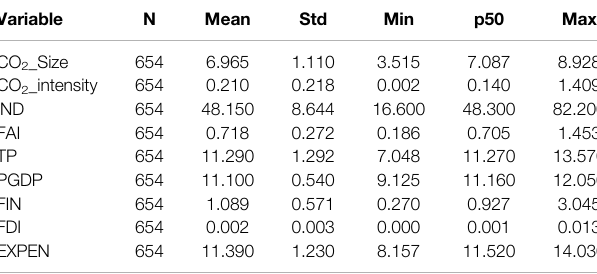
TABLE 1 | Descriptive statistics of the variables. Variable